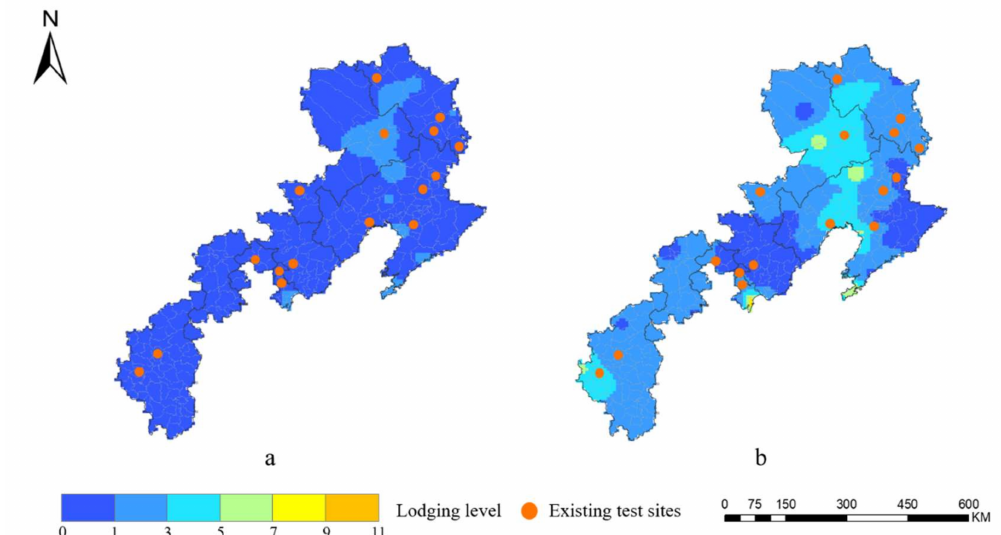
Figure 9. Lodging risk level for existing test sites. Levels 0 to 11 are lodging occurrence times in sensitive growth stage while lodging degree is partial and above, ( a , b ) represent the level of root and stalk lodging risk,